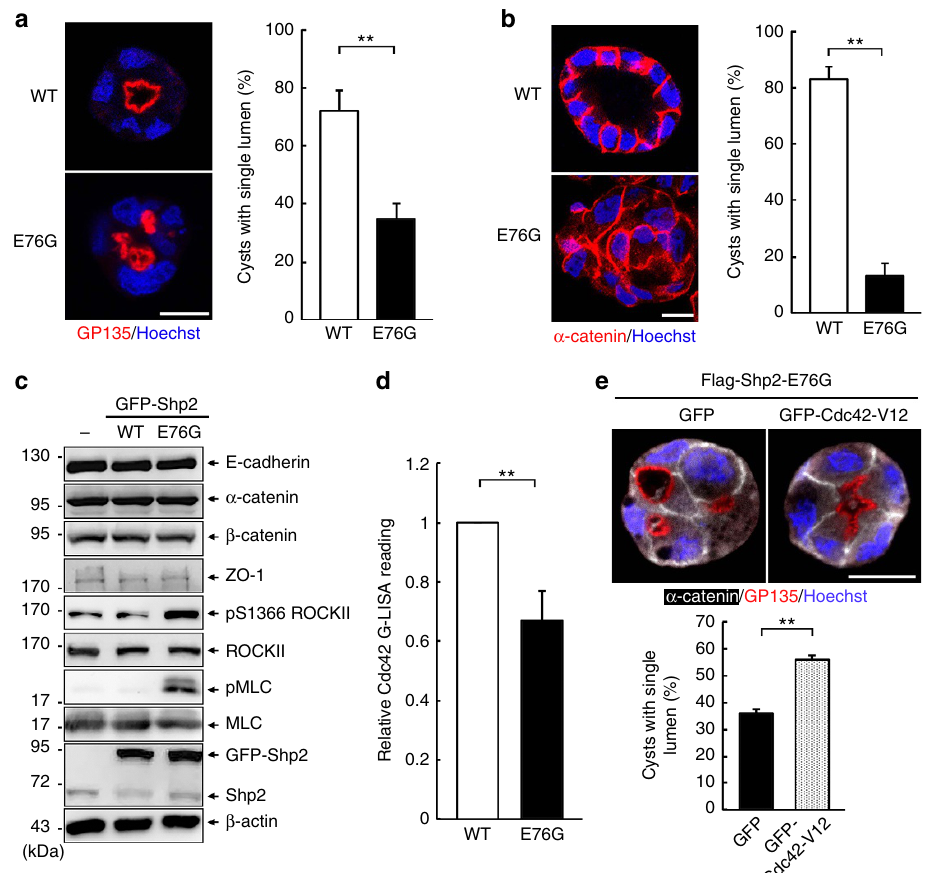
Figure 1 | Expression of oncogenic Shp2 impairs normal epithelial lumen formation through reducing Cdc42 activity. MDCK cells expressing GFP-Shp2- WTand GFP-Shp2-E76G were embedded in Matrigel. ( a ) After 2 days, cysts were extracted and fixed for immunofluorescence (IF) staining with antibodies as indicated. The percentage of cysts with single lumen is shown on the right (312–486 cysts were counted in each experiment, n ¼ 3). ( b ) After 7 days, cysts were extracted for IF staining, scale bar, 10 m m. Right panel shows the percentages of cysts with one single interior hollow lumen (584–767 cysts were counted in each experiment, n ¼ 3). ( c ) The 7-day cysts were harvested for western blot analysis with the indicated antibodies. ( d ) Cysts (2 days) were extracted for measuring the endogenous Cdc42 activity by G-LISA assay. ( e ) MDCK cells expressing Flag-Shp2-E76G were transfected with the expression vector of GFP or GFP-Cdc42-V12 and then embedded in Matrigel for 2 days. The formed cysts were fixed for IF stained. The percentage of cysts with single apical patch is shown below (203–241 green-positive cysts were counted in each experiment, n ¼ 3). Scale bars, 10 m m. All values are mean ± s.d. from three independent experiments; statistical significance was analysed by two-tailed unpaired Student’s t -test. * P o 0.05, ** P o